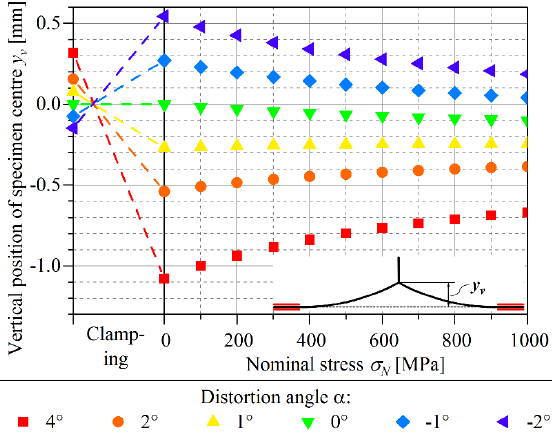
Figure 15. Vertical position of the specimen centre during clamping and loading.